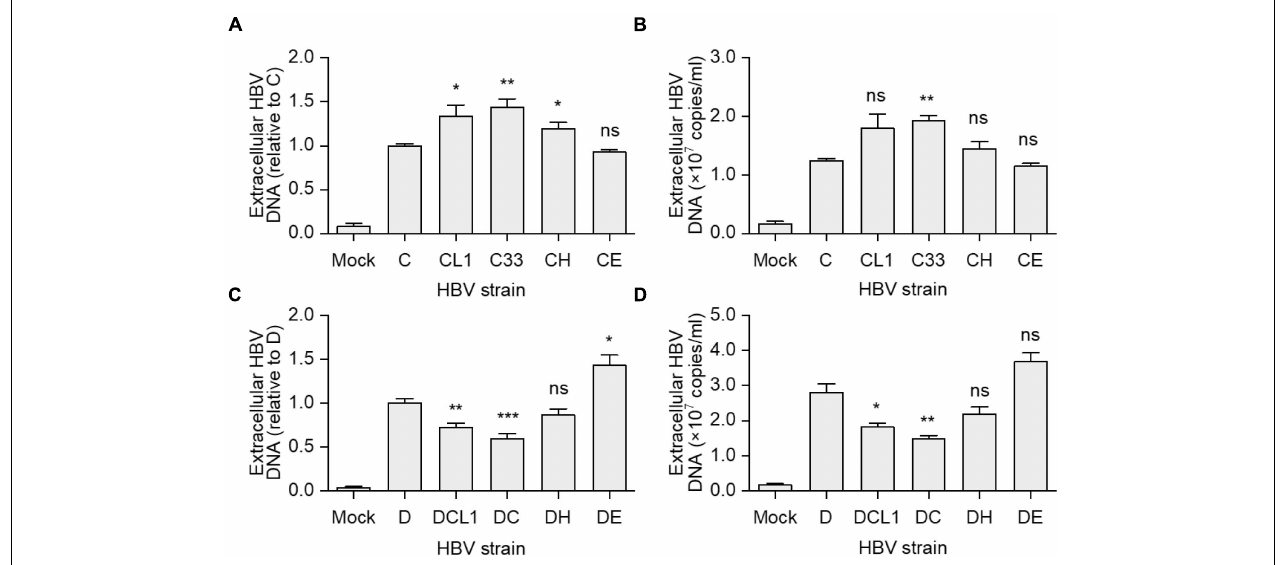
FIGURE 4 | Impact of preS1 N-terminal sequences on extracellular HBV DNA levels. HepG2 cells were transfected with plasmids containing 1.3-mer HBV genomes from C-derived (A,B) or D-derived (C,D) strains. (A,C) Data represent means ± SEM from two independent experiments, and the value for C or D strain were normalized as 1.0. (B,D) The histograms show mean values from one representative experiment; the bars indicate Standard Deviation. The p values were determined using Student’s t test; ns represents no significant, * p < 0.05, ** p < 0.01, *** p < 0.001. HBV, hepatitis B